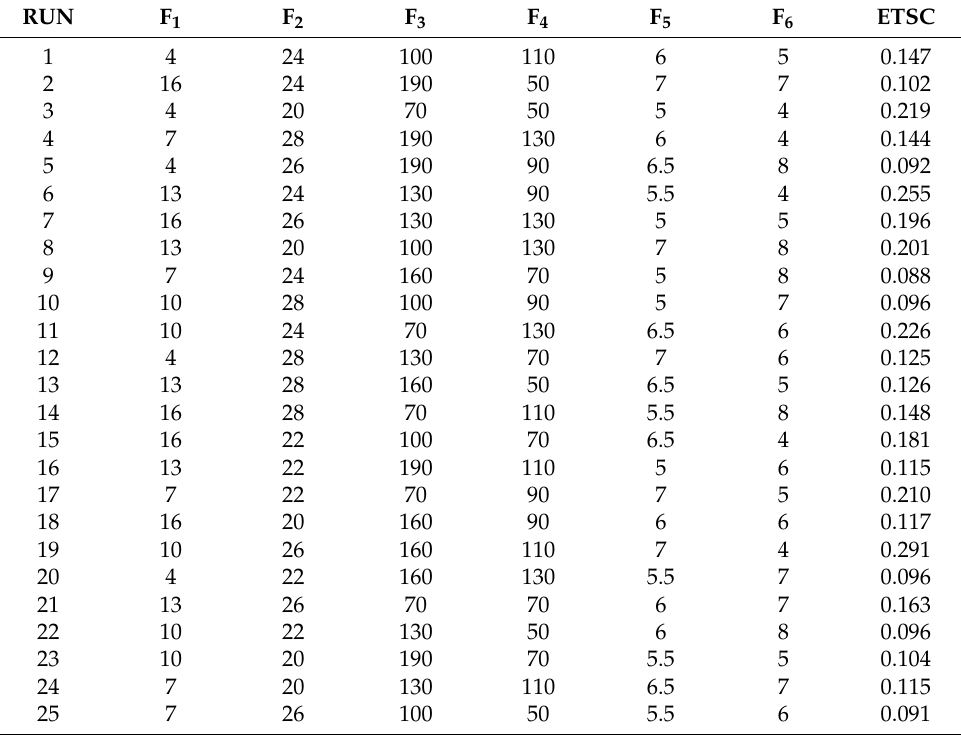
Table 4. The designs and results of the orthogonal experiments for culture condition